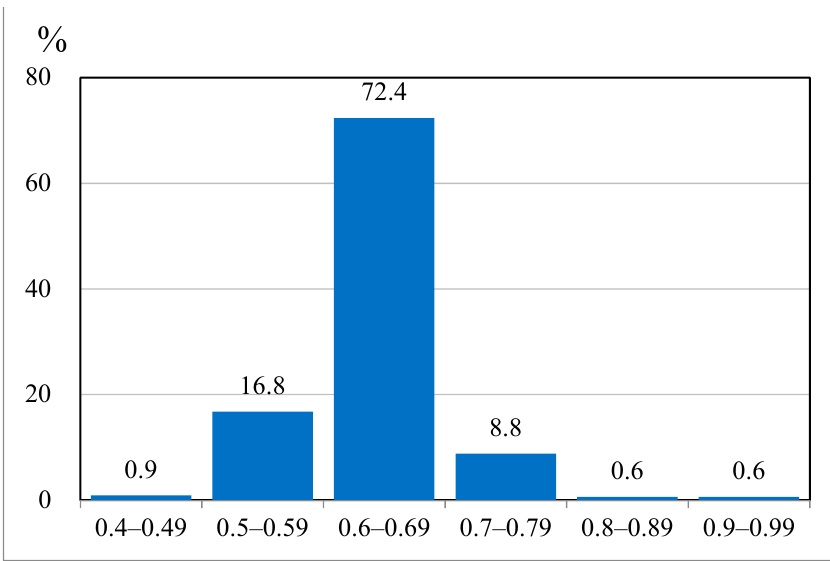
Figure 7. Distribution of metafrontier technical efficiency (MTE) scores.